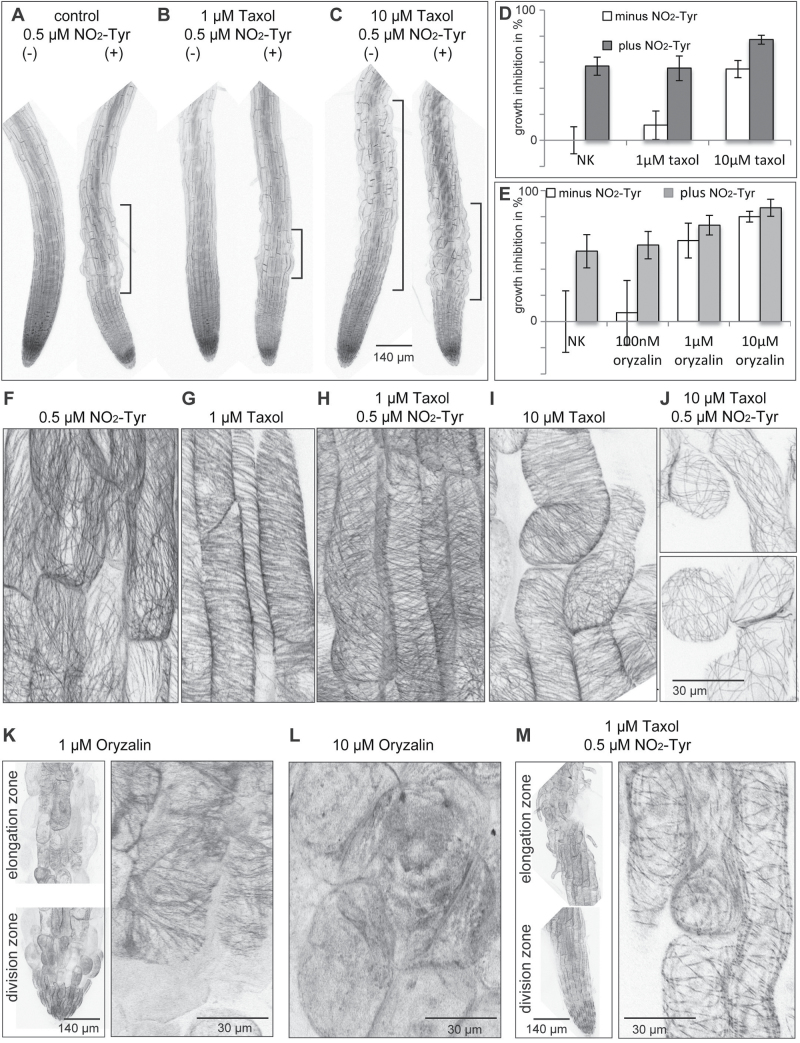
Effects of NO2-Tyr in combination with taxol or oryzalin. (A–C) Seedling morphology of (A) control without (–) and with (+) 0.5 μM NO2-Tyr. (B and C) Taxol treatment as indicated without (–) and with (+) 0.5 μM NO2-Tyr. (D and E) Growth inhibition is displayed as a percentage of untreated controls. (D) White columns show growth inhibition with taxol only. Grey columns show growth inhibition in the presence of 0.5 μM NO2-Tyr. Error bars indicate ±standard deviation (n≥24). (E) Normalized growth inhibition as a percentage of control. White columes show growth inhibition with oryzalin only. Grey columes show growth inhibition in the presence of 0.5 μM NO2-Tyr. Error bars indicate ±standard deviation (n≥27). (F–M) Microtubule (MT) organization in the presence of drugs as indicated. (K and M) Left panel: morphology of the elongation zone and division zone upon drug treatment as indicated.